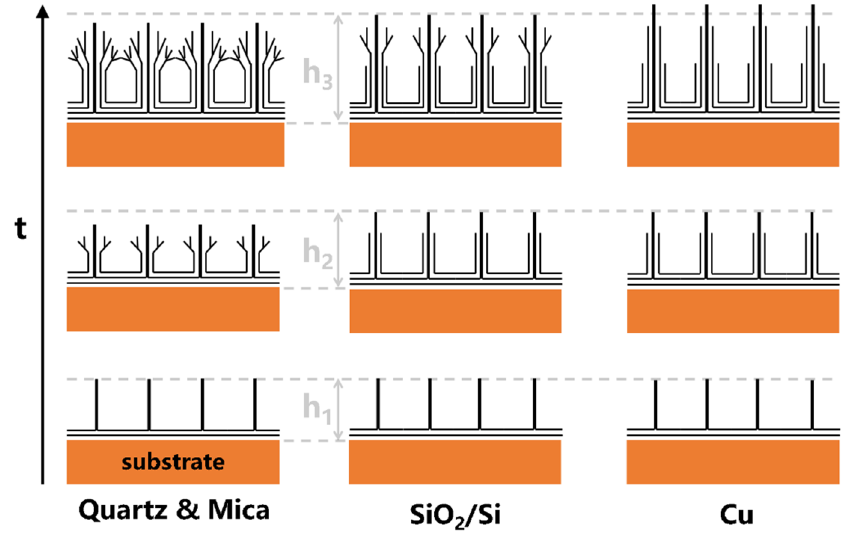
Figure 4. Growth pattern of VG on quartz & mica, SiO 2 /Si & Cu substrates. The ordinate represents growth time & h means total VG height (h1 < h2 < h3).